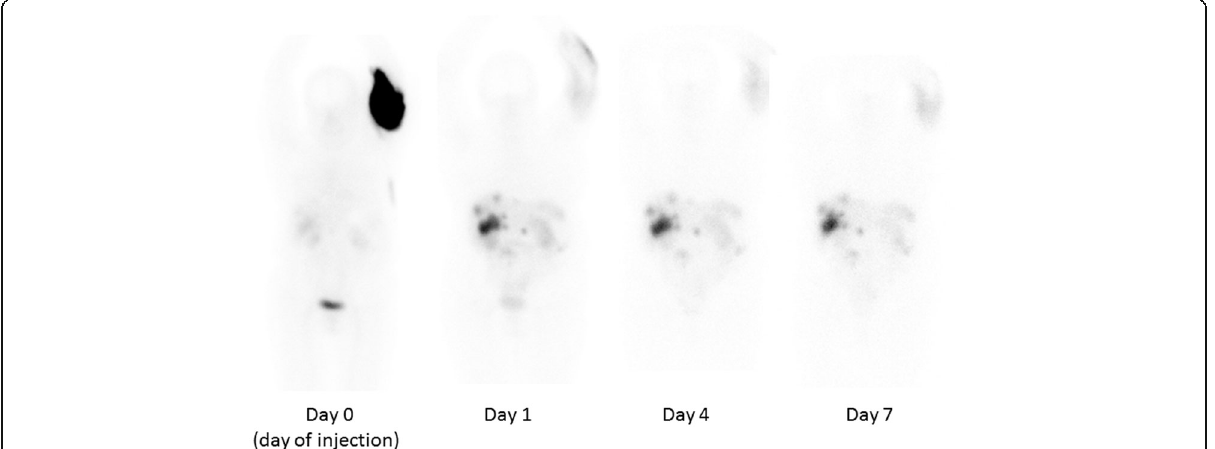
Fig. 1 Anterior views of whole-body scintigraphies performed at day 0, day 1, day 4 and day 7. The activity initially located in the arm is redistributed to organs and tumors in the abdominal